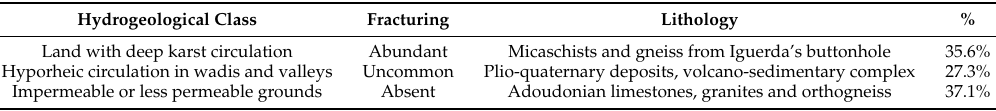
Table 4. Hydrogeological classes of the investigated